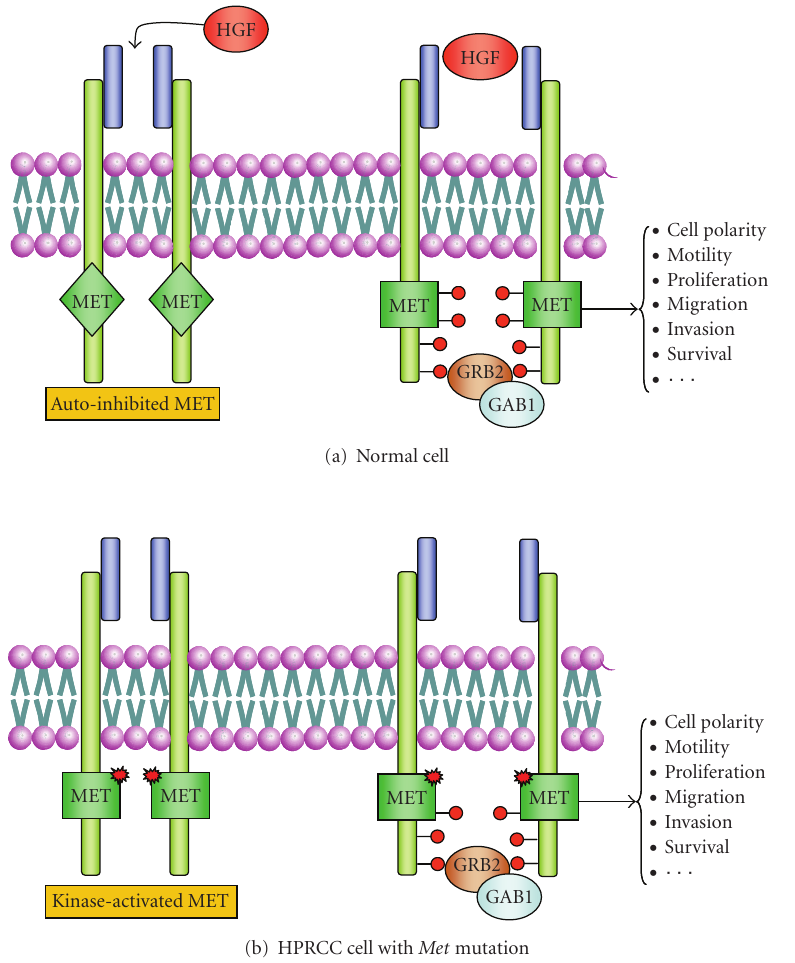
Figure 3: Activating mutations in MET in HPRCC. (a) In normal cells, hepatocyte growth factor (HGF) binds to MET receptor to induce MET dimerization and release autoinhibition. This permits, through several phosphorilation steps, the activation of second-messenger molecules (such as GRB2, GAB1, or PI3K) leading to morphogenic, motogenic, and mitogenic programmes. (b) Renal cells from patients with HPRCC can harbour germline mutations in the tyrosine kinase domain of MET. These mutations release the autoinhibition by the MET carboxyl terminus, allowing the transition of the receptor to the active kinase form in absence of ligand